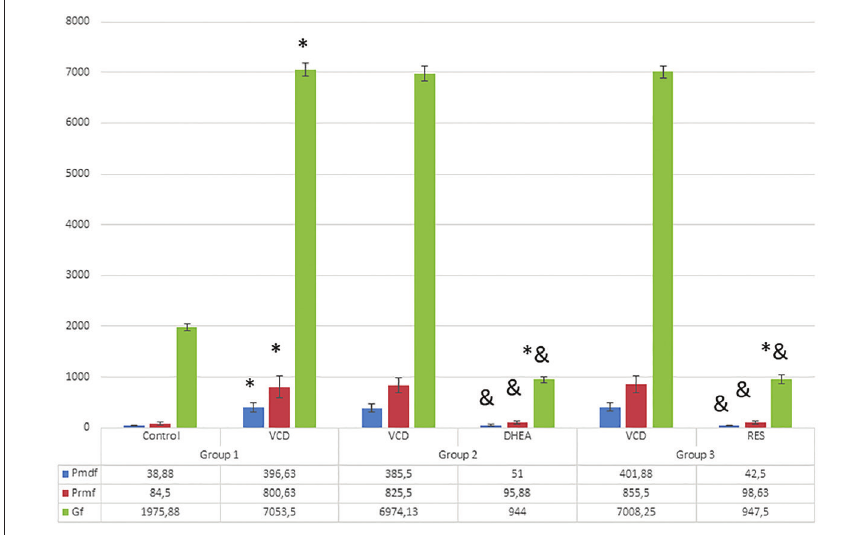
Figure 3. Comparison of primary, primordial, and growing follicle apoptotic cell numbers. (*): Different from control, (&): Different from VCD (p<0.05) Table 1. Serum FSH, E2, AMH values